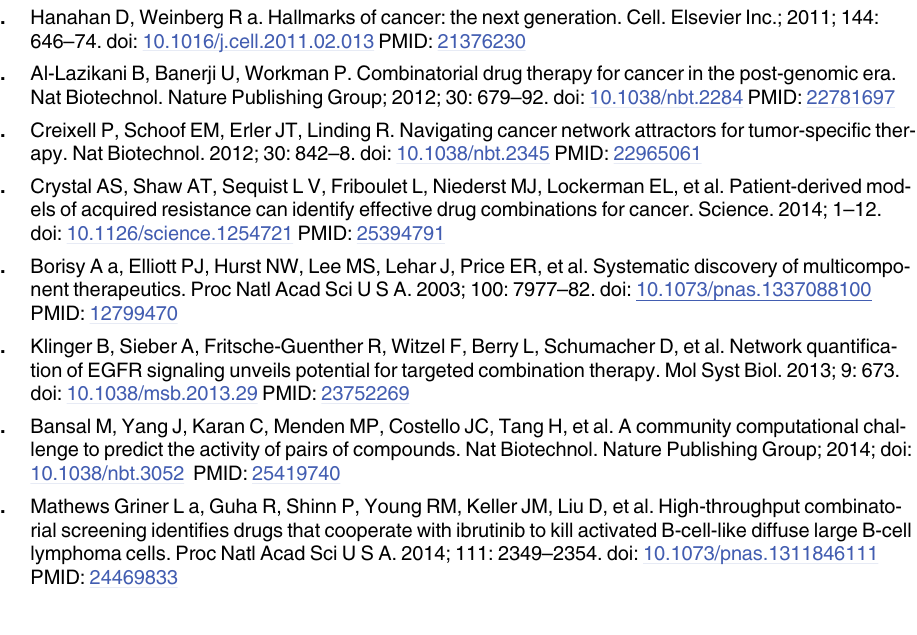
S3 Table. Comparison of stable state of logical model and literature-derived steady state signaling. S4 Table. Summary of literature-derived steady state signaling observations. S5 Table. List of 77 logical equations encompassed by GINsim model. S6 Table. Literature review of perturbation experiments in AGS cells. References to publica- tions describing 56 observations of signal transduction perturbation responses in AGS cells. S7 Table. Logical parameters for reduced logical model. S8 Table. Compressed logical rules for reduced logical